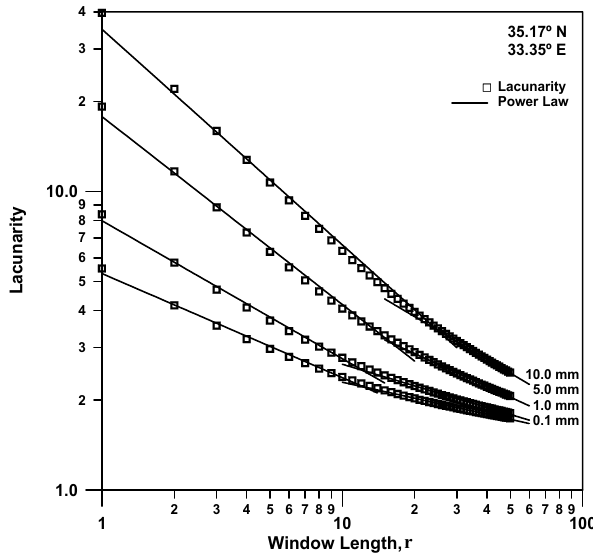
Fig. 2. An example of lacunarity curves for a daily rainfall series and the four thresholds (0.1, 1.0, 5.0 and 10.0mm/day).